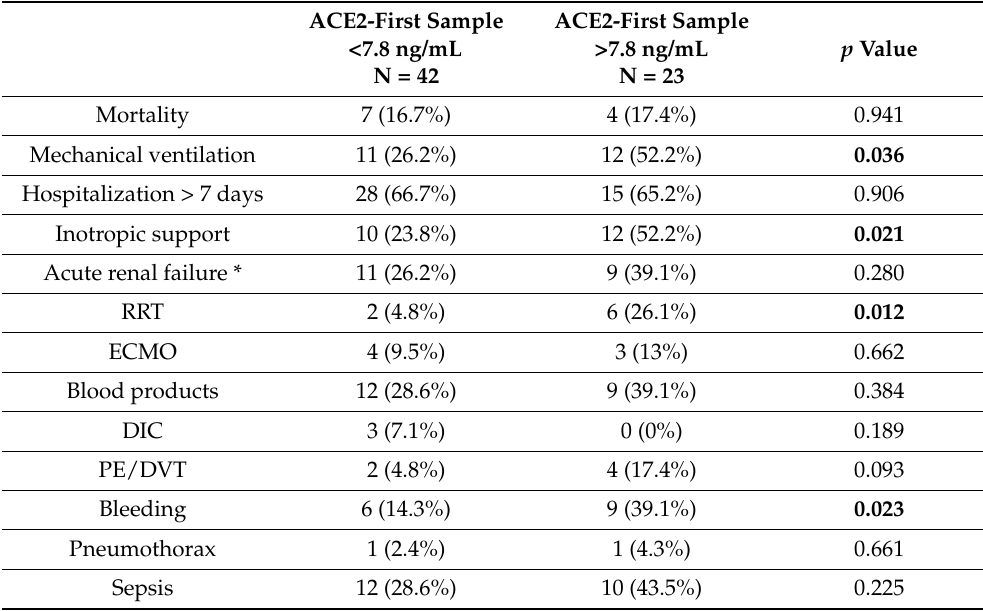
Table 2. Clinical outcomes of COVID-19 patients with high (>7.8 ng/mL) and low ACE2 levels (<7.8 ng/mL) (as per ROC